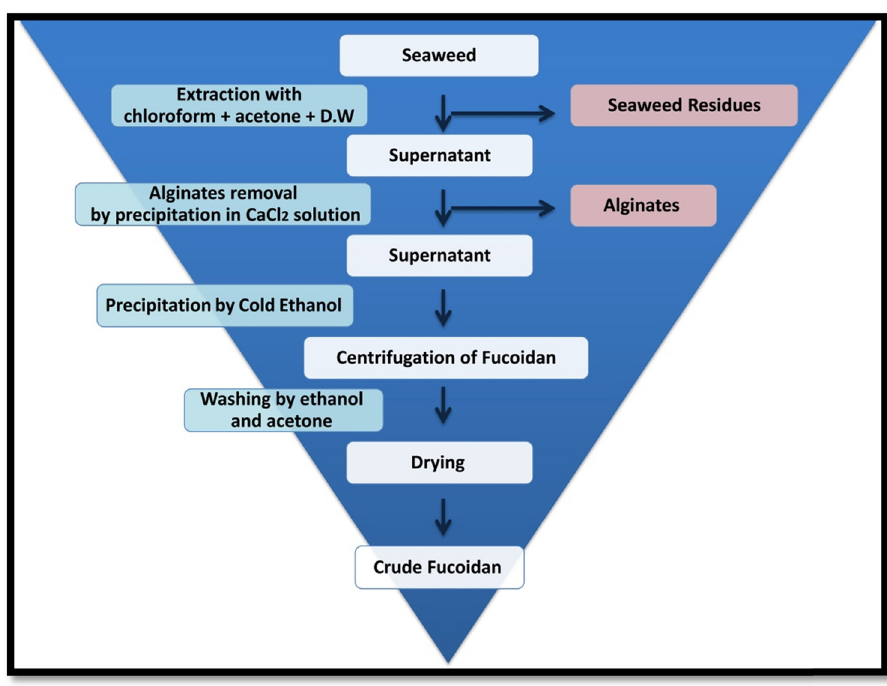
Figure A1: Schematic fl owchart illustrated the step - by - step protocol used for Fu extraction from C. barbata